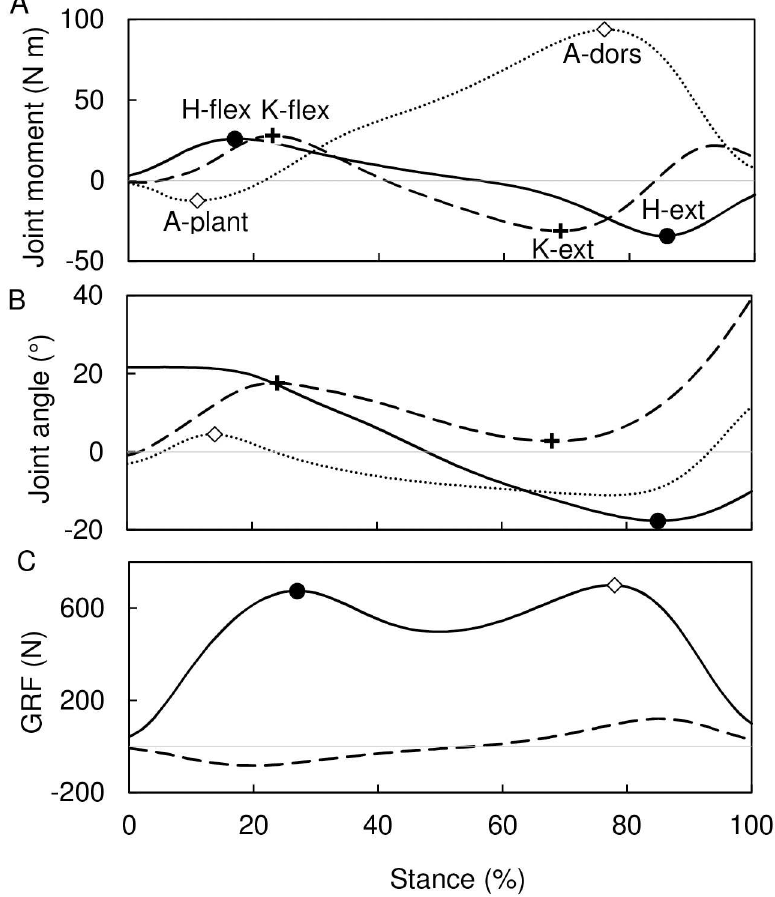
Fig 3. Determination of gait events used to track the peak net joint moments. (A) Illustrative joint moments at the hip (solid line), knee (dashedline), and ankle (dotted line) with peak moments indicated. (B) Samplemean angulardisplacement of the hip (solid line), knee (dashedline), and ankle (dotted line) with gait events used to track peak moments indicated(open diamond, A-plant; crosses, K-flex and K-ext; filled circle, H-ext). (C) Samplemean vertical groundreaction force (solid line) and estimated antero-posterior ground reactionforce (dashedline) with gait events used to track peak moments indicated(filled circle, H-flex; open diamond, A-dors). See text for definitionsof peak moments and gait